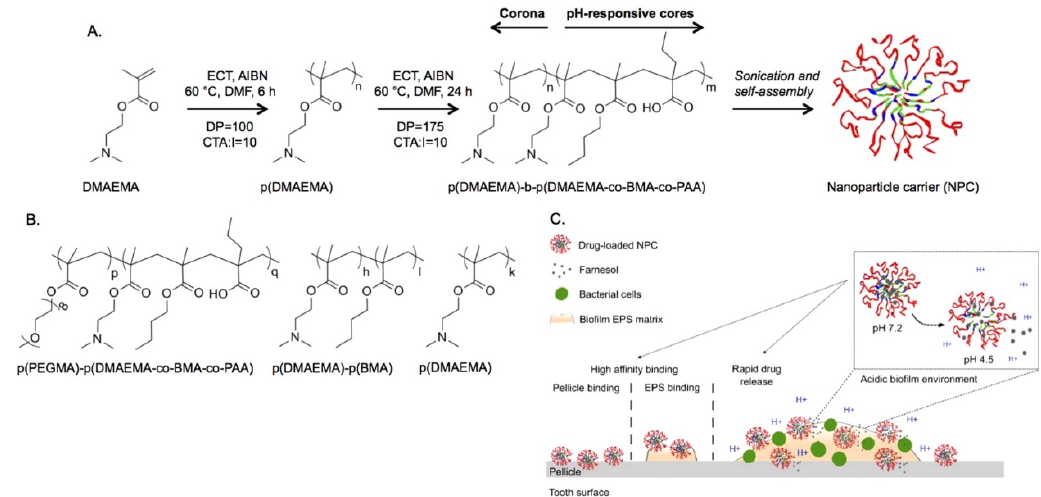
Figure 3. Synthesis and function of polymeric nanocarriers of farnesol and their antibiofilm activity [70]. ( A ) Depiction of the chemistry and self ‐ assembly of diblock copolymers. ( B ) Structures of control polymers utilized to isolate the required physicochemical characteristics for binding to dental surfaces. ( C ) Proposed mode of action of pH ‐ responsive nanoparticles for the prevention and/or treatment of biofilms. Reprinted with permission from (ACS Nano). Copyright (2015) American